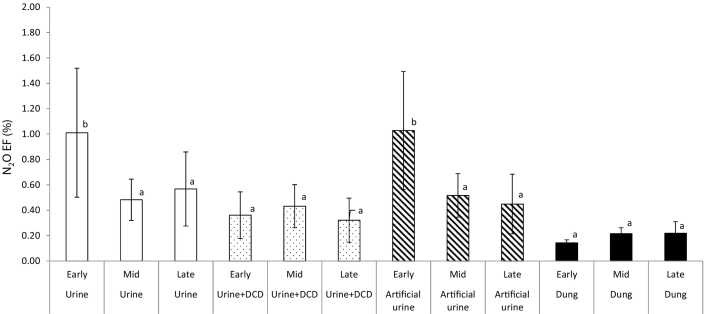
Effect of urine/dung treatment application timing (across all sites) on average N2O EF.Within each treatment, average N2O EFs (from meta-analysis) between timings of application with different letters are significantly different (N = 3, vertical lines are standard error of the mean).